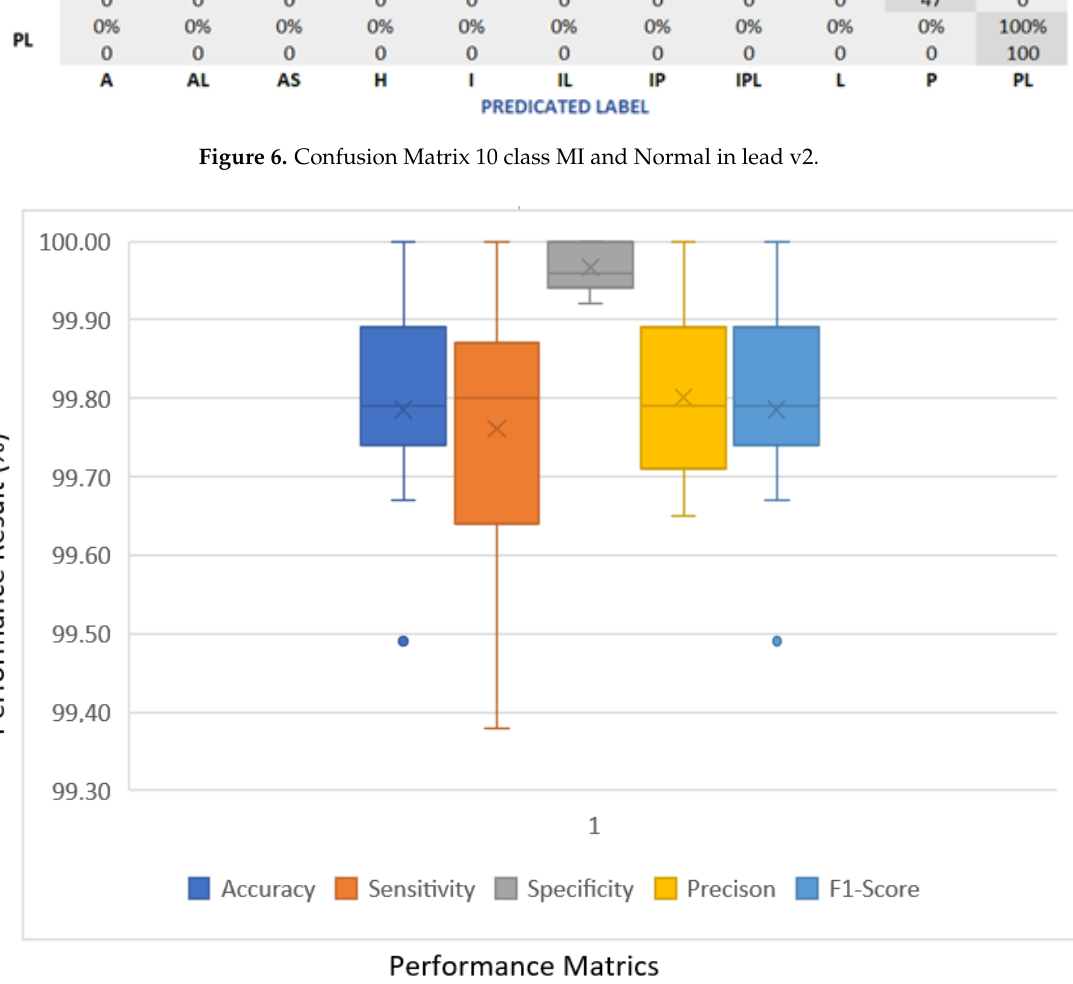
Figure 7 . Boxplot Performance Result (%) in 15 ECG leads for 10 classes MI and normal . Table 4. Performance result (%) 15 lead ECG. Table 4 shows the performance result values for accuracy, sensitivity, specificity, preci- sion, and F1-score in 15 ECG leads and Table 5 shows the performance matrix values for 10 MI and normal